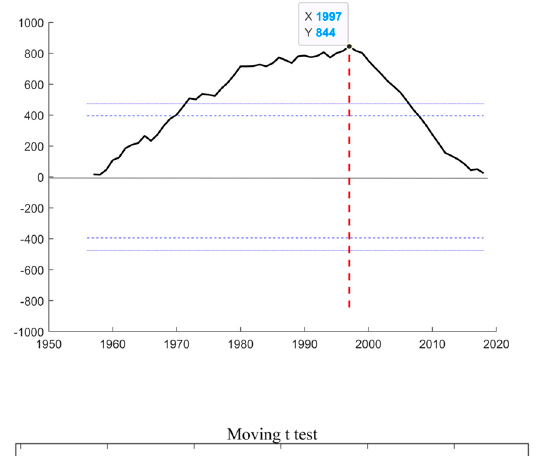
Table 2. Meteorological data and the parameters (n) of three Budyko formula for two periods.